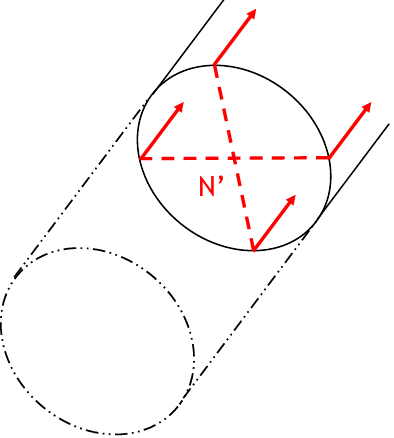
Figure 2. SCP, imaginary shaft node.